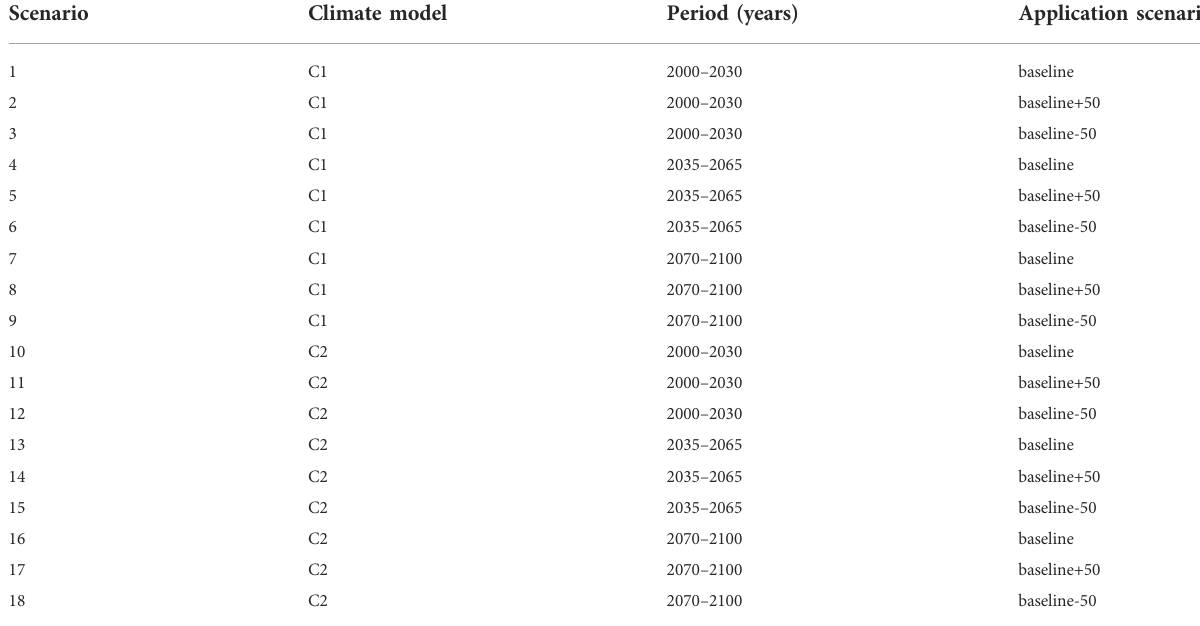
TABLE 3 Overview of scenarios used in the Bayesian network model combining the three scenario components Climate model, Period and Application scenario. For description of the climate models, see Section 2.2.1.1. For de fi nition of the pesticide application scenarios, see Table 2.